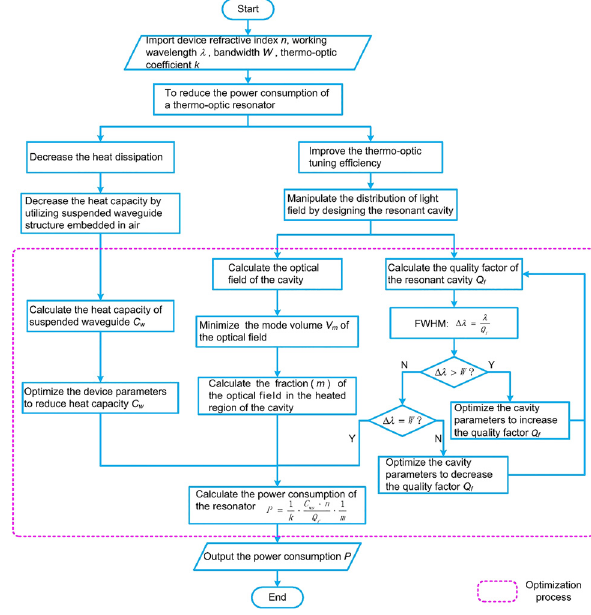
Figure 1: Flow chart for the optimization process of a low-power- consumption thermo-optic (TO)